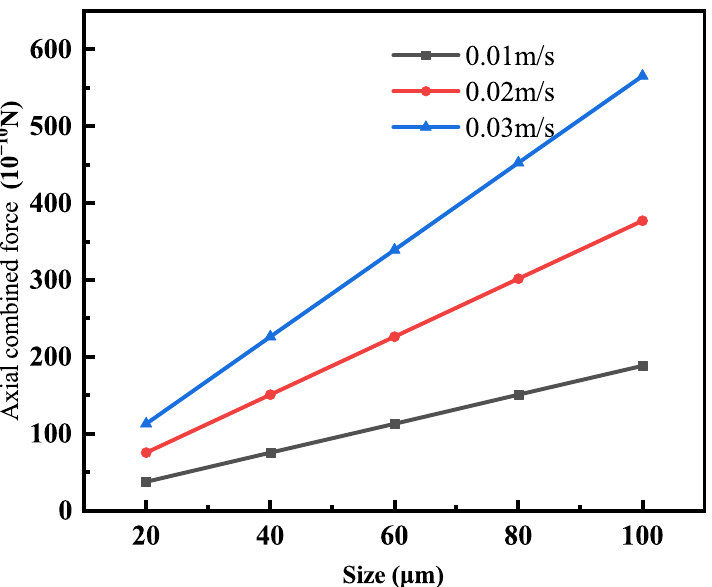
Figure 11. The relationship between axial force and axial flow velocity for different particle sizes. Mineral particles in the axial direction is not only by the water flow axial trac- tion, but also by the action of friction on the surface of the sorting cylinder Figure 10b. Among them, ilmenite by the size of the friction force and the radial direction by the size of the combined force, and because the particles are in the sorting cylinder wall with the sorting cylinder to do uniform circular motion, at this time the particles by the size of the radial combined force is equal to its centrifugal force. When the speed is 200 rpm, different particle sizes of the axial force and axial water flow velocity of the relationship was showed between Figure 12a,b. As the axial flow velocity increases, the axial force on the particles increases; when the particle size increases, the axial force on the particles increases and then decreases, and the increase in the process of increasing is becoming smaller and smaller, indicating that the same axial water flow velocity, the larger the particle size is, the more difficult it is to move from the inner surface of the sorting cylinder towards the outer surface of the outlet under the action of the water traction, and it is easier to stay in the sorting cylinder with the rotation of the sorting